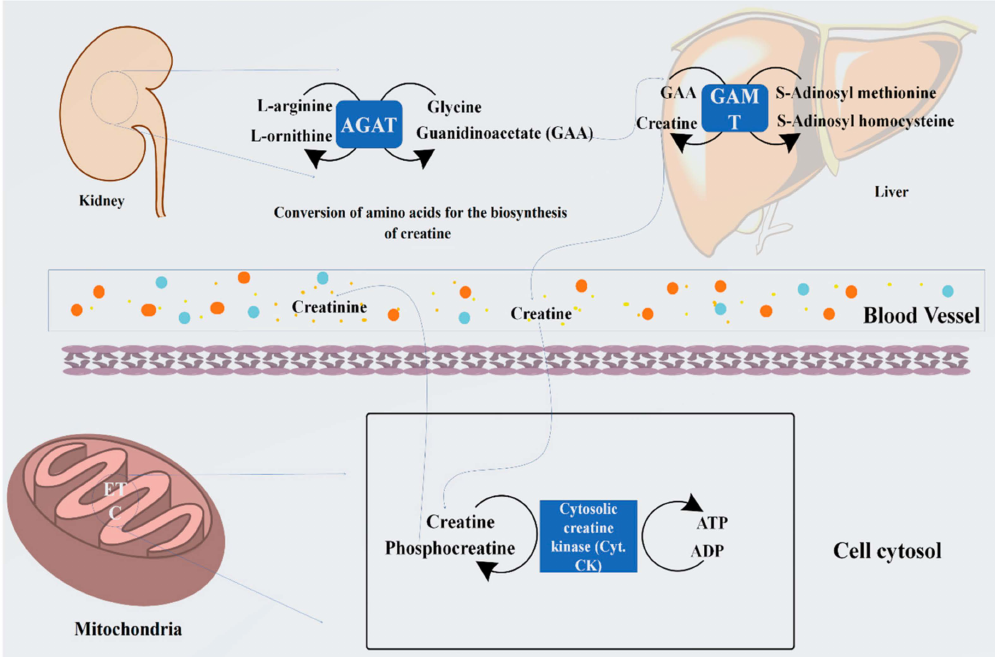
Figure 1. Representation of biosynthesis of creatine from arginine and glycine by the enzyme arginine: glycine amidinotransferase (AGAT) to guanidinoacetate (GAA) and its methylation by guanidinoac- etate N-methyltransferase (GAMT) using S-adenosyl methionine to form creatine. Furthermore, its cellular compartment conversion into phosphocreatine (PCr) by the cytosolic enzyme creatine kinase produces several folds of energy, such as